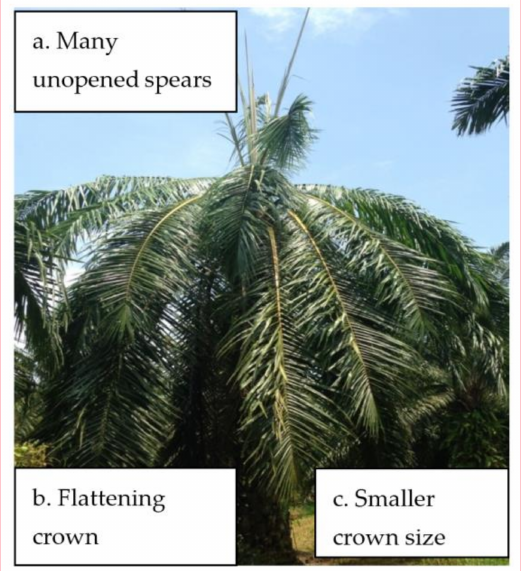
Figure 1. Foliar symptoms of an oil palm crown severely infected with basal stem rot (BSR) disease: ( a ) many unopened spears, ( b ) flattening crown, ( c ) smaller crown